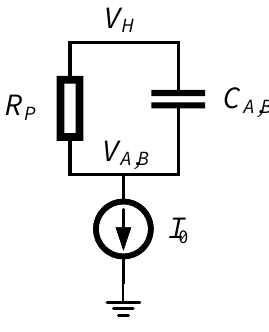
Figure 5. Equivalent circuit during the fall time of V A , B